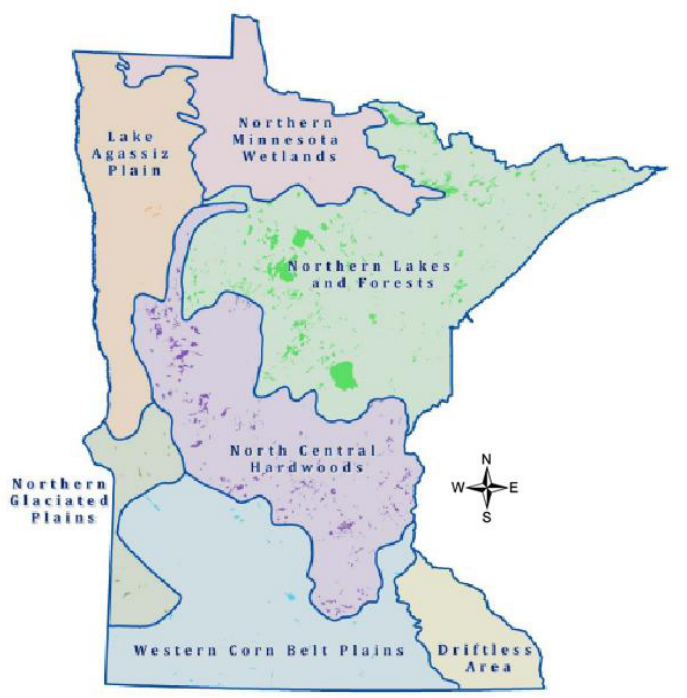
Figure 4. US EPA ecoregion boundaries across